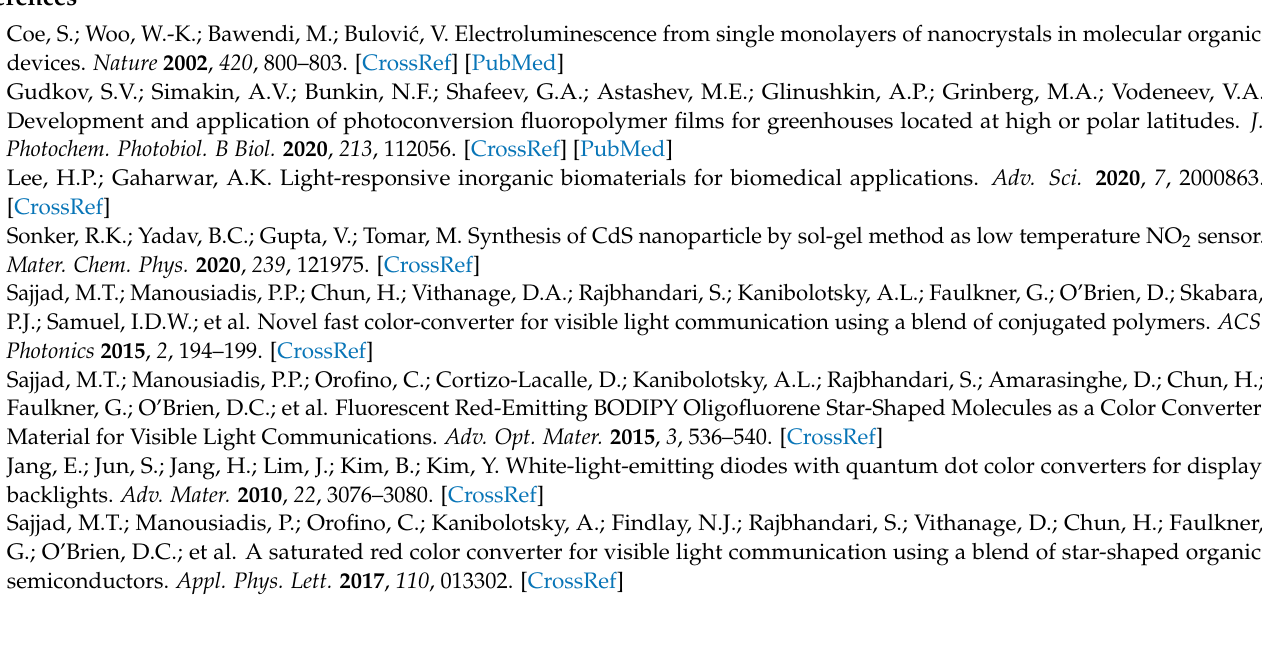
C, 150 ◦ C and 170 ◦ C for 15 min. PL spectra were obtained using excitation wavelength of 330 nm; Figure S3. Fluorescence images of nanocomposite films of Ppy9 and CdDMASe before (left) and after baking at 170 ◦ C for 15 min (right). These images were captured with a fluorescence microscope using an excitation wavelength of 355 nm; Figure S4. Larger view of the film during the heating process indicating the CdSe QDs distribution within the film under different baking conditions: (a) unbaked film, (b) film at 140 ◦ C with small crystals presence, (c) film at 150 ◦ C with presence of CdSe QDs and initial aggregation process (clusters of QDs); (d) film at 170 ◦ C film with several clusters of QDs; Figure S5. Cross sections of the unbaked (a) and baked films at 140 ◦ C (b), 150 ◦ C (c) and 170 ◦ C (d). In each panel the AFM image of the film (on the left, consider Figure 4 in the manuscript) and the cross-section (right) measured along the line marked 1 in each AFM image is shown. In order to compare the morphology of each film, the depth of voids statistically present on the film surface are also given; Figure S6. Energy levels of polymer Ppy9 and CdSe, showing type 1